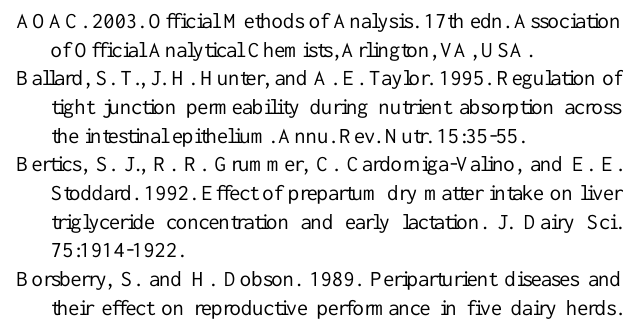
2 p-value is for partial regression coefficient of multiple regression analysis. 3 β, the standardized partial regression coefficient of multiple regression